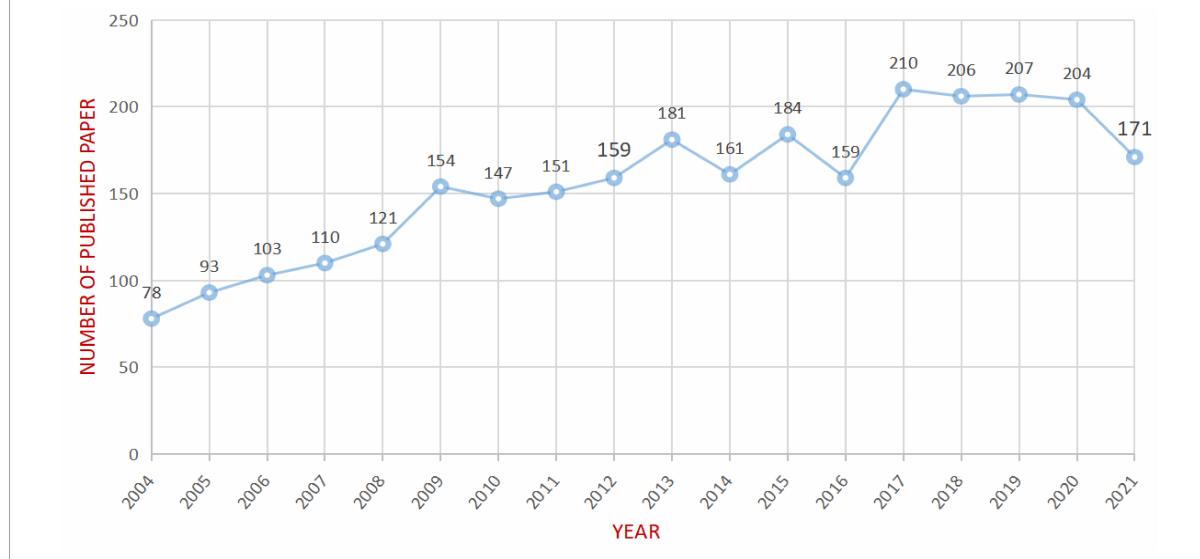
FIGURE2 Annual trend chart of publications.